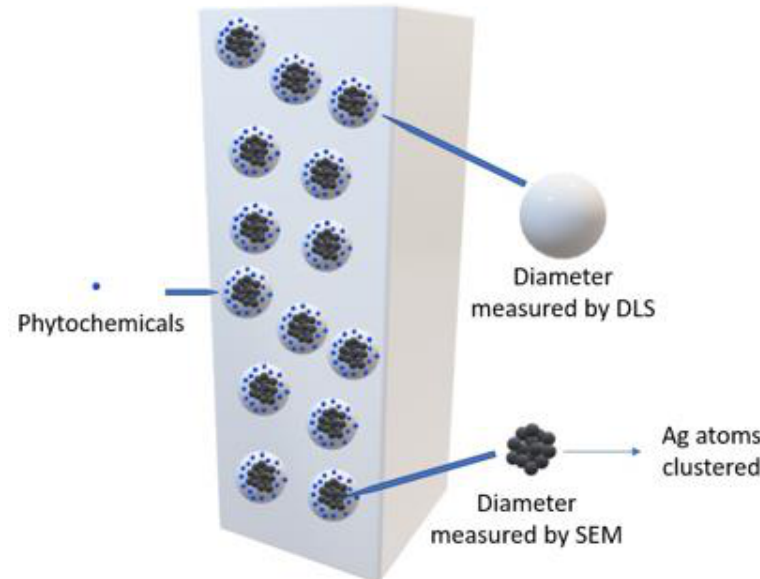
Figure 9. Diagram of the hydrodynamic diameter of AgNPs.